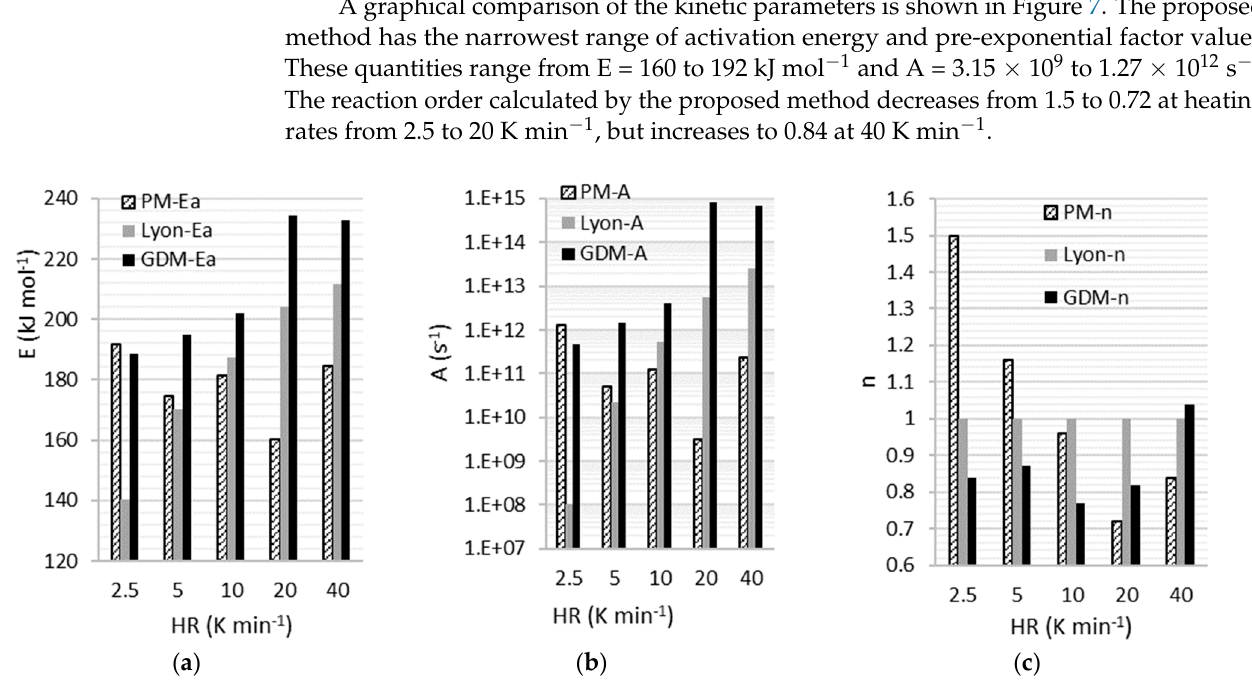
Figure 7. A comparison of ( a ) activation energy, ( b ) pre-exponential factor, and ( c ) the reaction order of PA 6.6 decomposition as a function of heating rate by different kinetic methods.